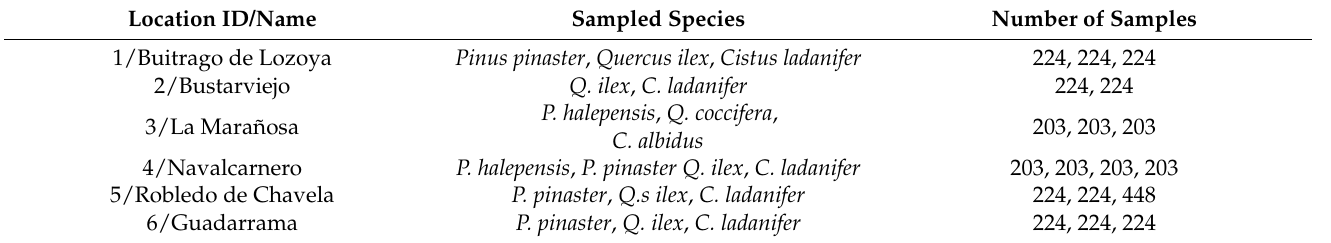
Table 1. Field samples, by species, collected at each